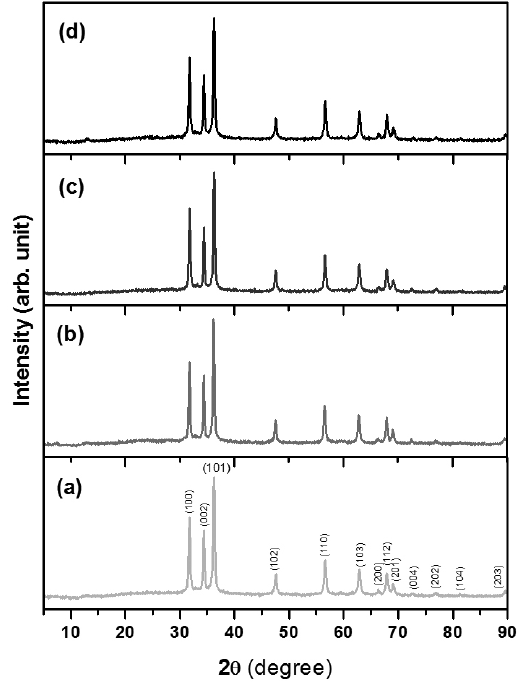
Figure 5. XRD patterns of samples: (a) G1, (b) G2, (c) G3 and (d)